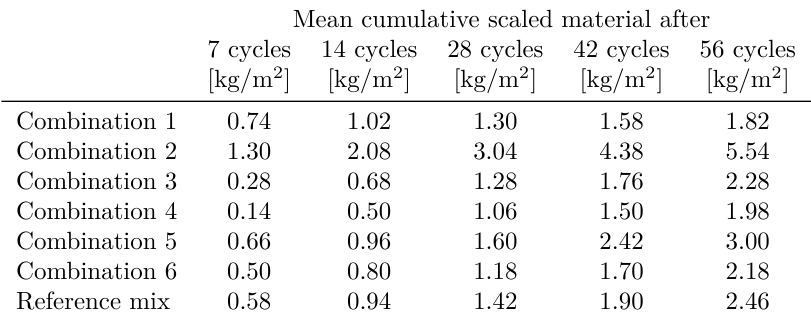
Table 6. Freeze-thaw resistance of the concrete mixtures with maximum aggregate replacement.